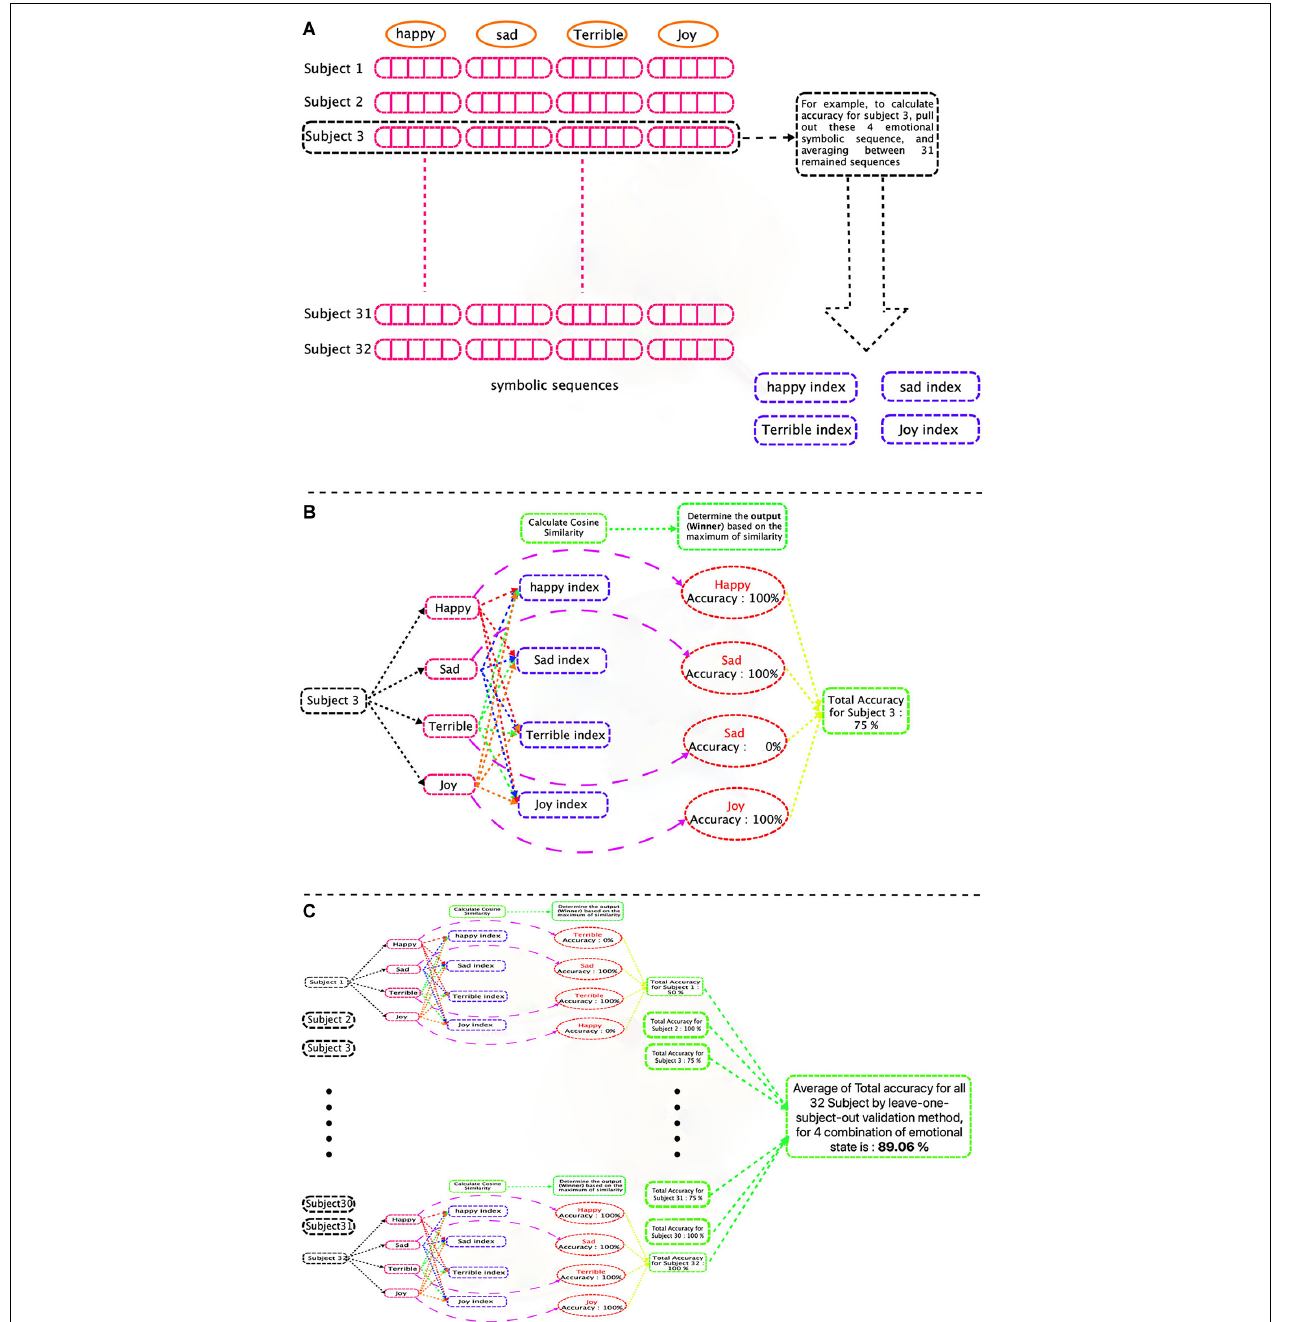
FIGURE 9 | Graphical flowchart of classification process of a signal (four groups of emotions case). (A) Training phase and calculate emotional indices. (B) Test Phase. Each test subject’s EEG emotional symbolic sequence, is compared to four symbolic indexes (for each emotion) and based on the maximum value of the cosine similarity, is assigned to one emotional group and finally, the accuracy is calculated. (C) Calculate total accuracy for all